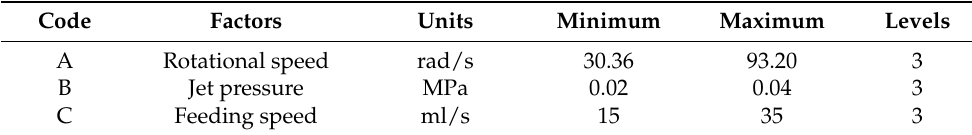
Table 2. Test factors and levels of centrifugal separation tests.